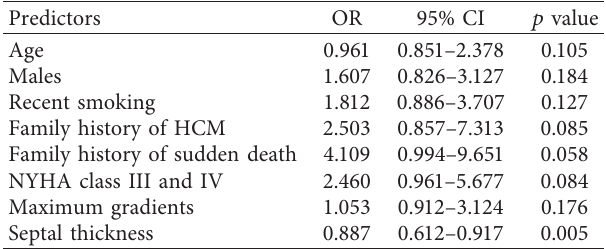
Table 2: Independent association between baseline variables and concomitant subvalvular